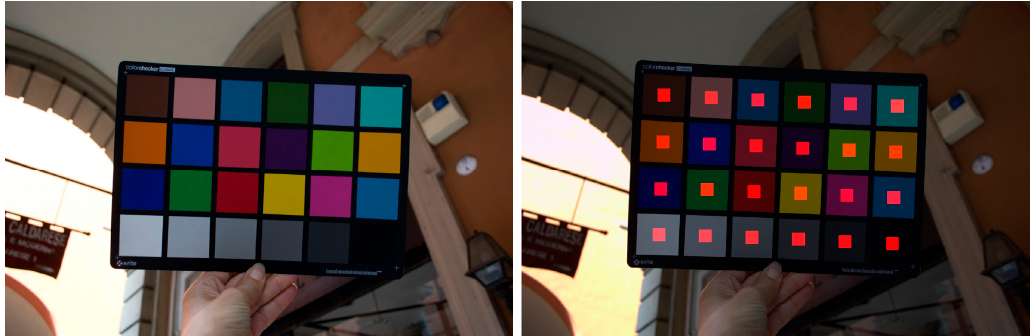
Figure 4. Result of CC detection.